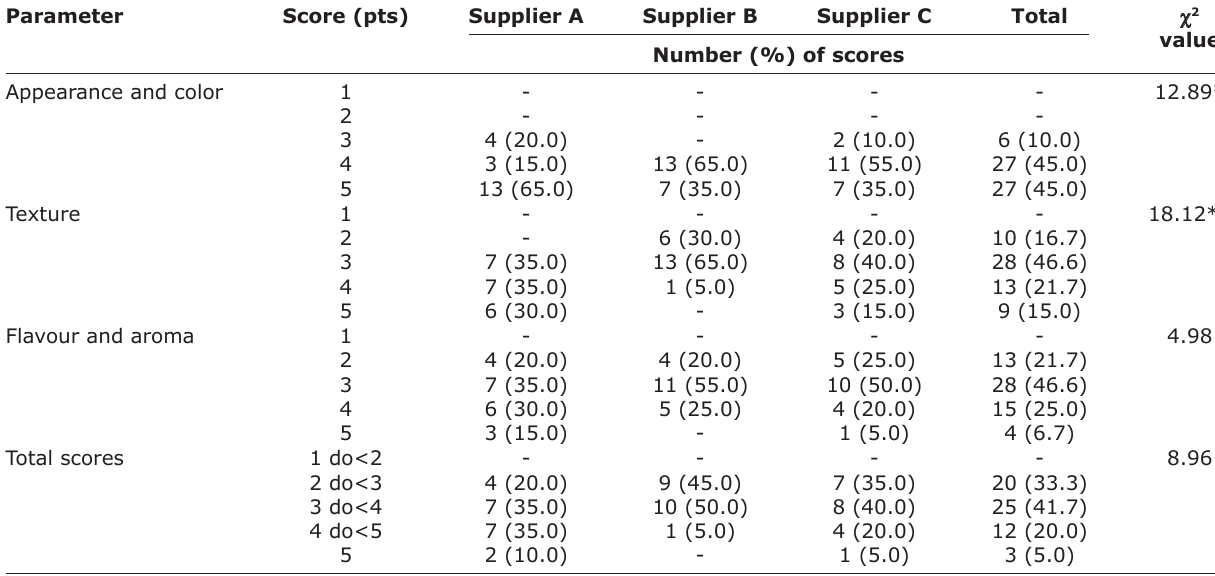
Table-6: Frequency of scores given by the panelists in organoleptic evaluation of the curd cheese samples.